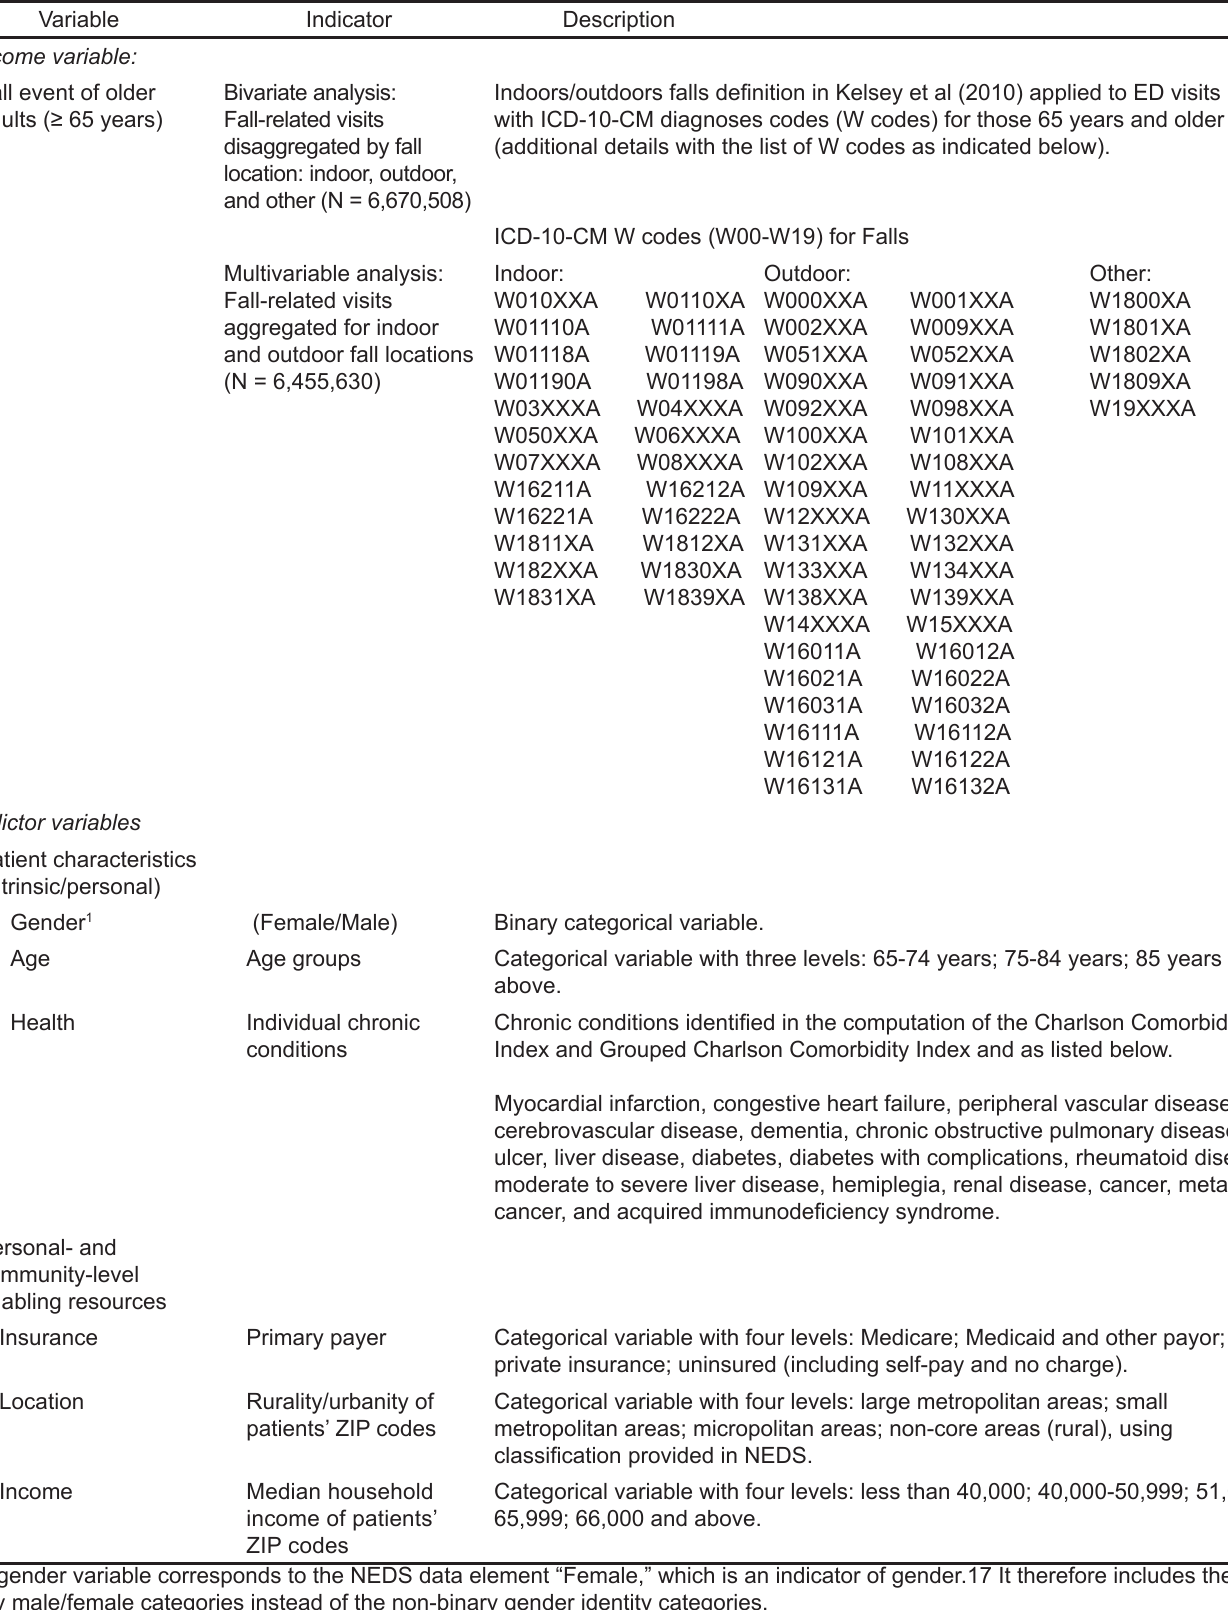
Table 1. List of variables included in the bivariate (chi-square) and multivariable (logistic regression)